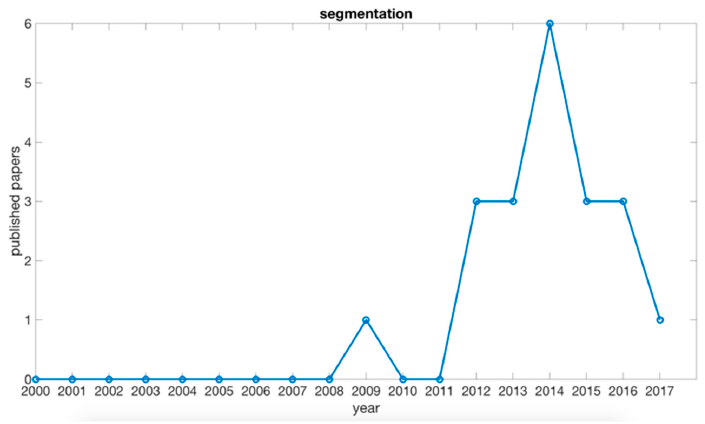
Figure 7. Number of published papers by year for filter research papers.